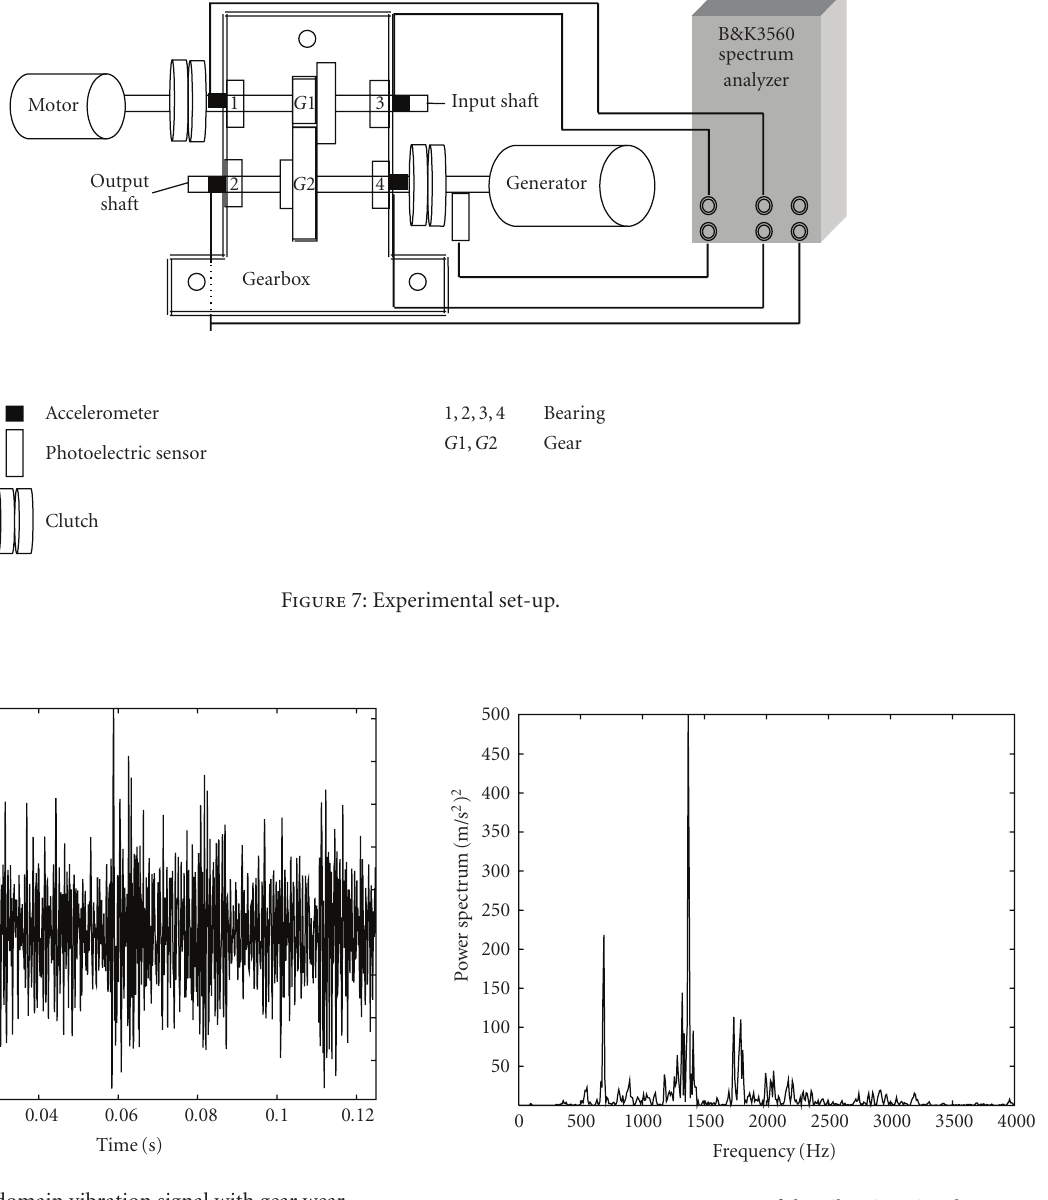
Figure 8: Time-domain vibration signal with gear wear. Figure 9: Power spectrum of the vibration